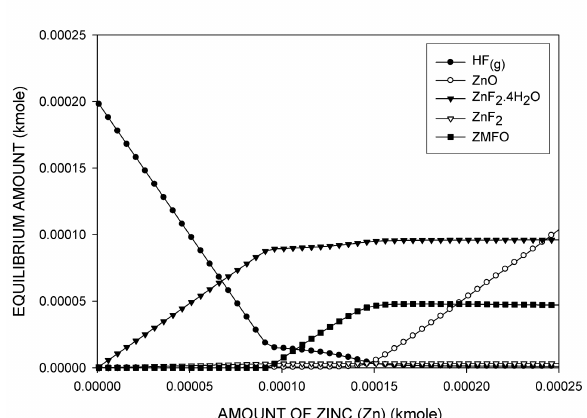
Figure 6. Effect of temperature on the equilibrium amounts of the zinc-containing species in the Zn-Fe-Mn-O-H-C-F system.